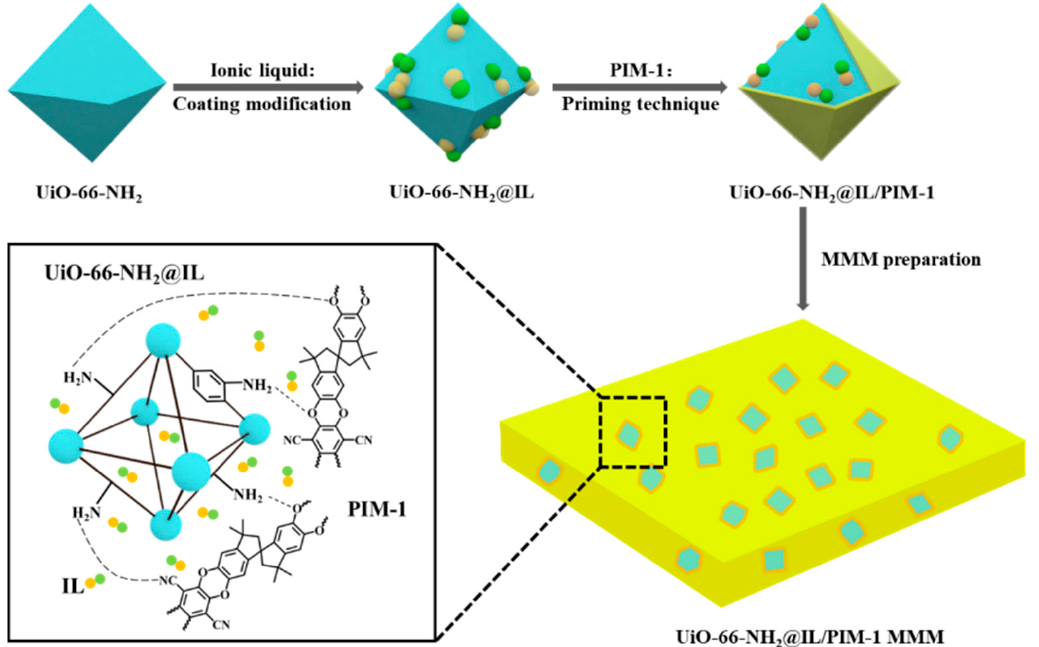
Figure 1. Schematic of the preparation process of UiO-66-NH 2 @IL/PIM-1 MMM by coating modification and priming technique.